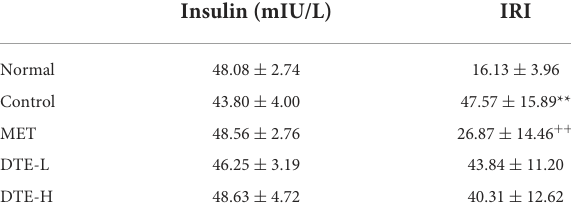
TABLE 2 The effect of DTE on insulin and insulin resistance index